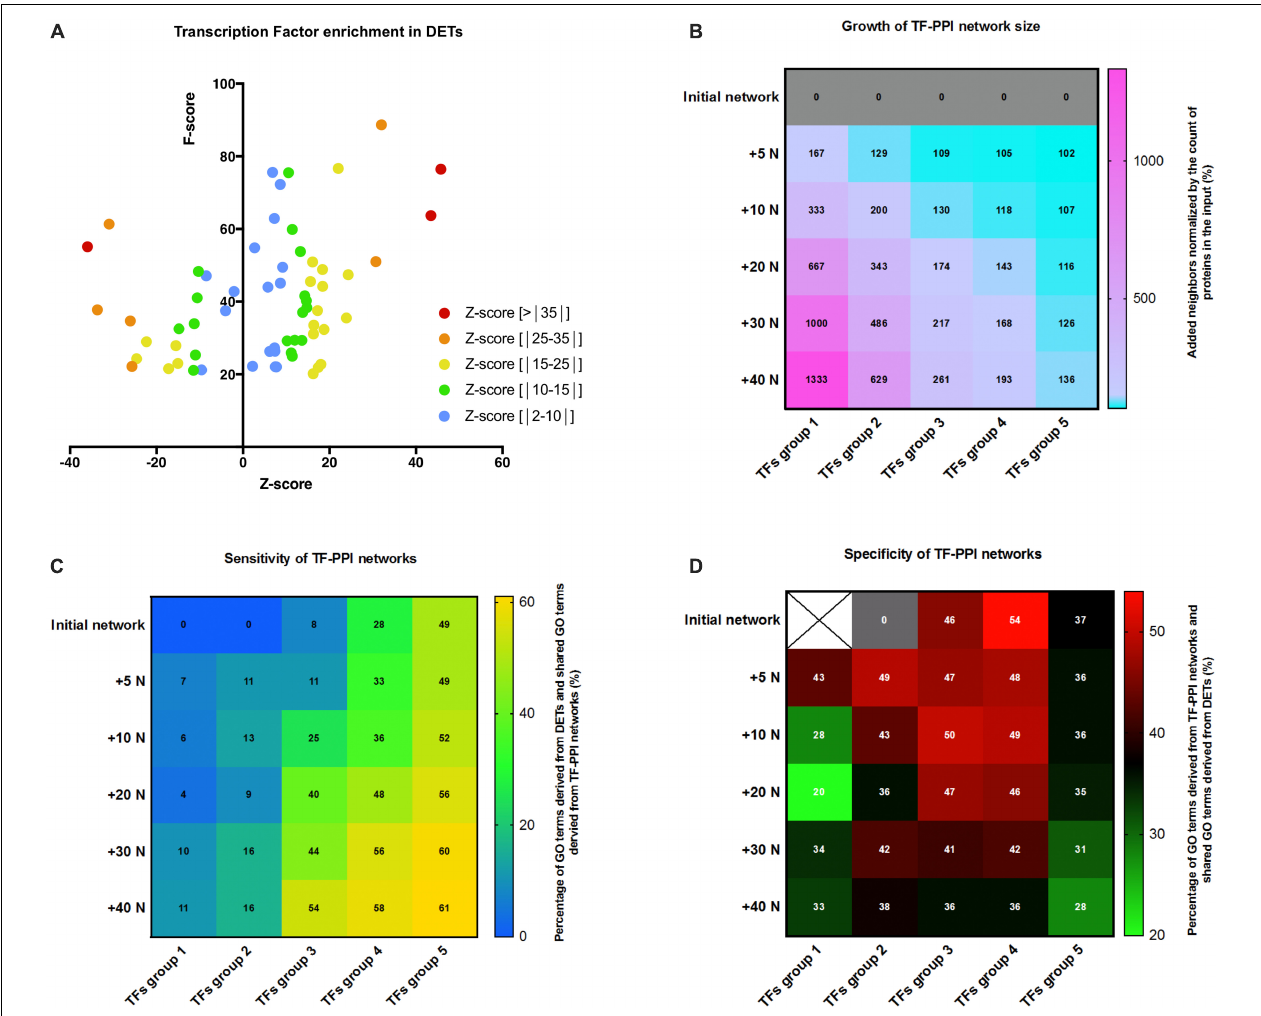
FIGURE 4 | Transcription factor analysis and PPI networks simulation. (A) Scatter plot of z -score and F -score of the over-represented transcription factor binding site (TFBS) detected in genes of the DET list and generated by oPOSSUM. Only TFs with F -score above 20 are considered. TFs were classified by their z -score as depicted in the legend. (B) Heat map showing the growth of TF-PPI network size as calculated by the percentage of increase in the number of proteins at each step of network growth: +5, +10, +20, +30, and +40 neighbors (+5 N; +10 N; +20 N; +30 N; +40 N). TF-PPI networks were simulated from each different TFs groups as input. TFs group were: group 1 ( z -score > | 35|), group 2 ( z -score > | 25|), group 3 ( z -score > | 15|), group 4 ( z -score > | 10|), and group 5 ( z -score > | 2|). (C) Heat map displaying the sensitivity of the networks based on the growth (increase in number of neighbors) and the input (groups of TFs) of TF-PPI. Color gradient displays the percentage of GO terms of all DETs shared with GO terms derived from TF-PPI network and values indicates the percentage. (D) Correlation matrix between the growth (increase in number of neighbors) and the input (groups of TFs) of TF-PPI networks reporting the specificity of the networks. Color gradient displays the percentage of GO terms of TF-PPI network shared with the DET-based GO terms and values indicates the